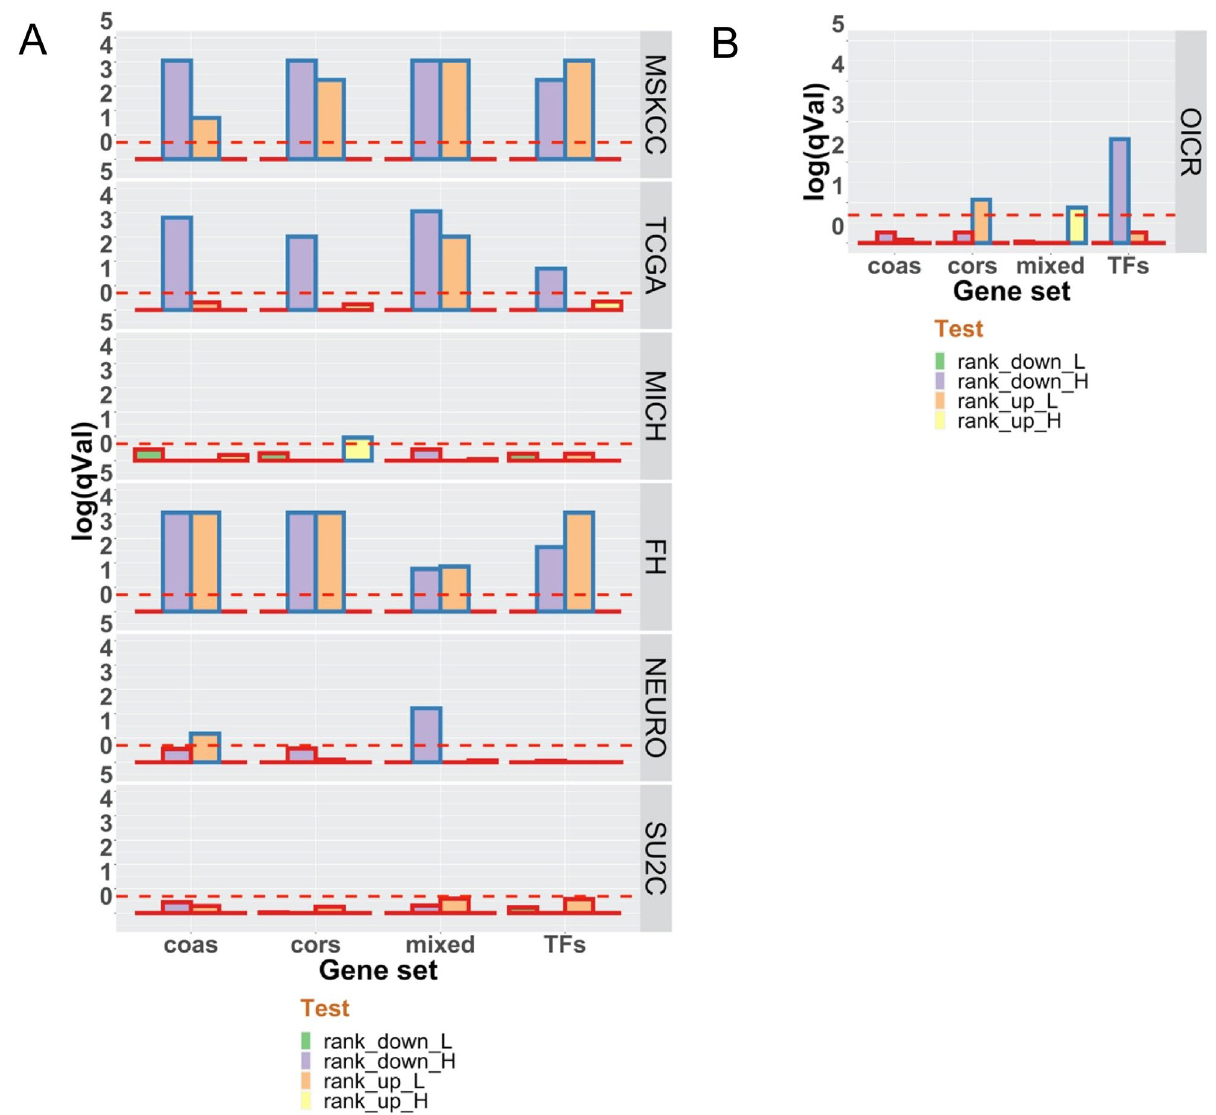
compared to the distribution of ranking of the same number of genes randomly sampled 100,000 times. The empirical p-values were − log10 transformed and FDR corrected for mRNA expression ( A ) and proteins ( B